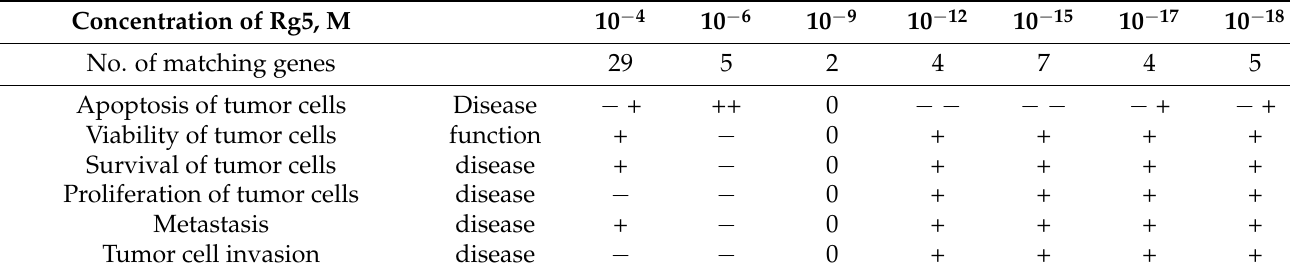
Table 7. The number of genes matching tumor microenvironment signaling pathway and predicted effects of Rg5 in various diseases and cellular processes associated with neurotransmission 1 . Concentration of Rg5,